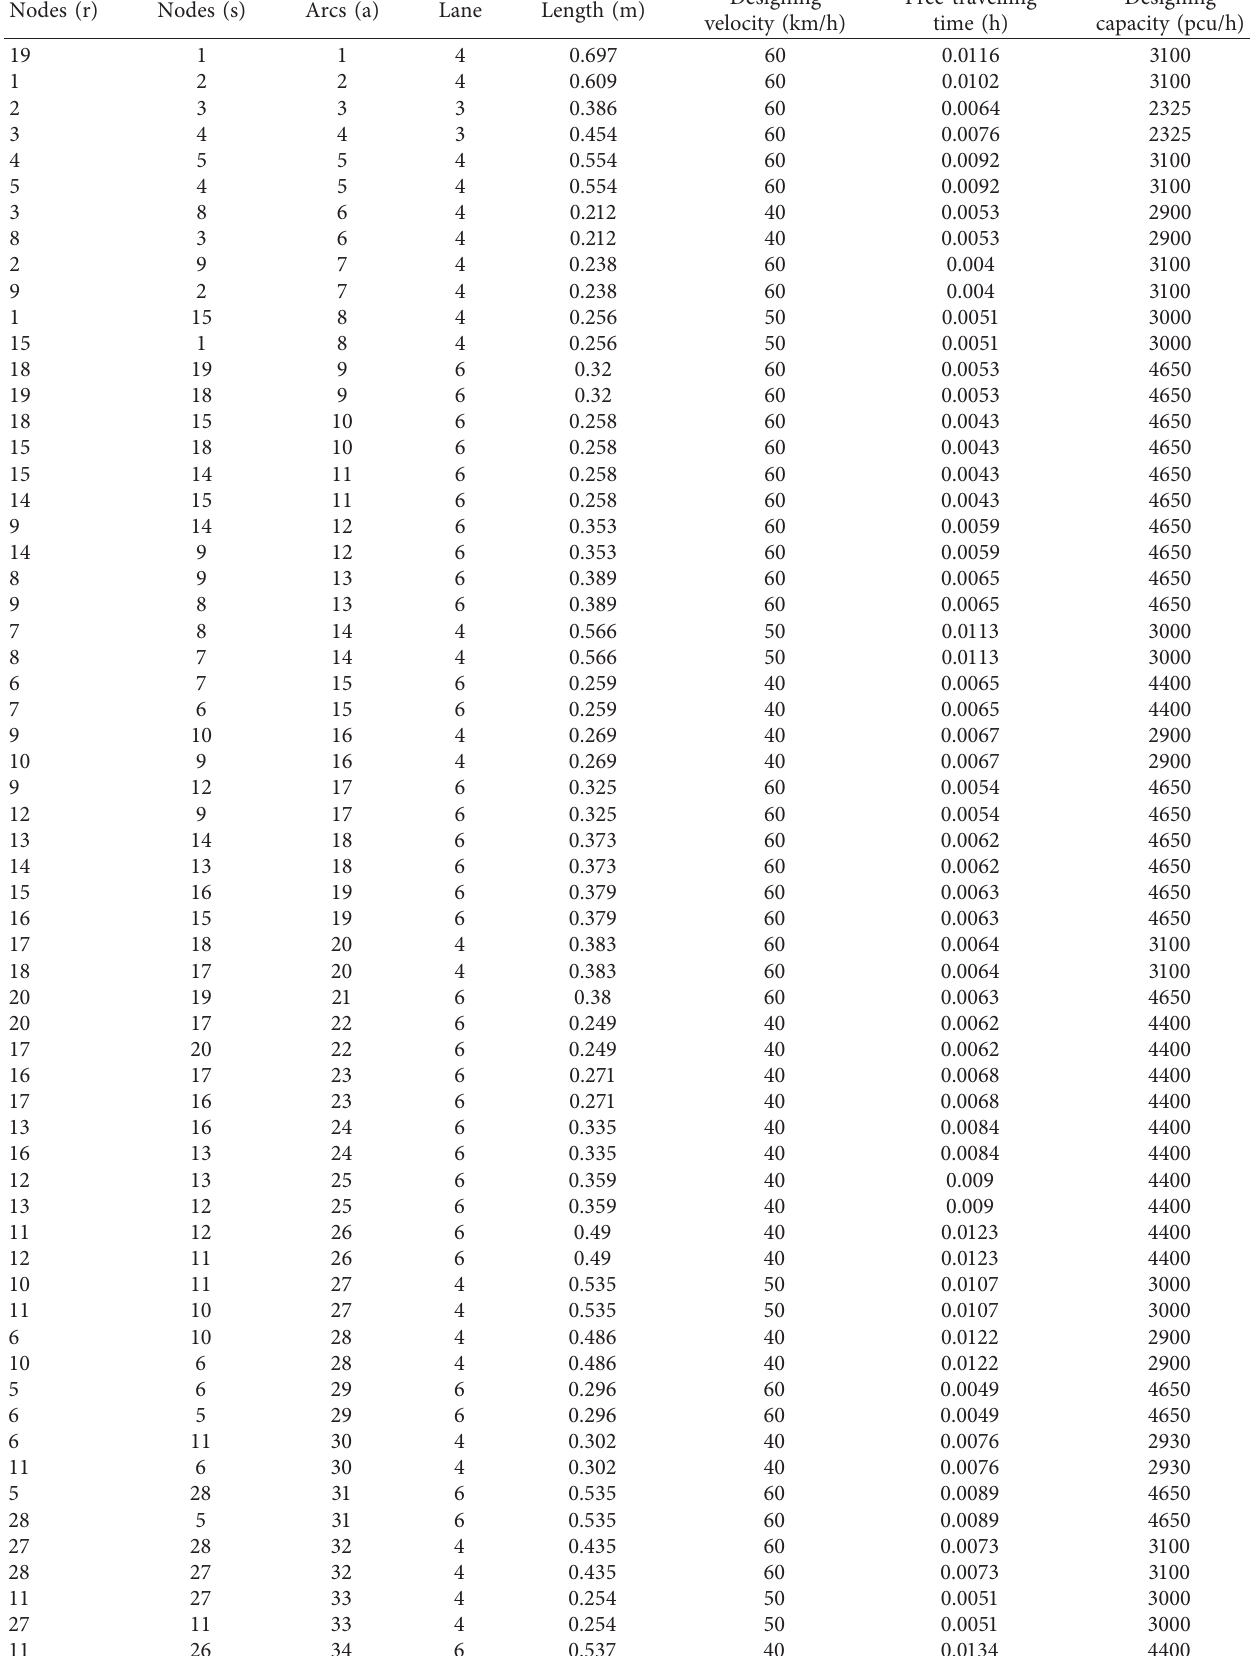
Table 2: Survey results of road traffic network